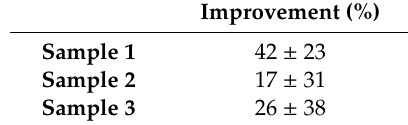
Table 5. Calculated improvement of Extracellular Vesicle (EV) isolation yields, combined.